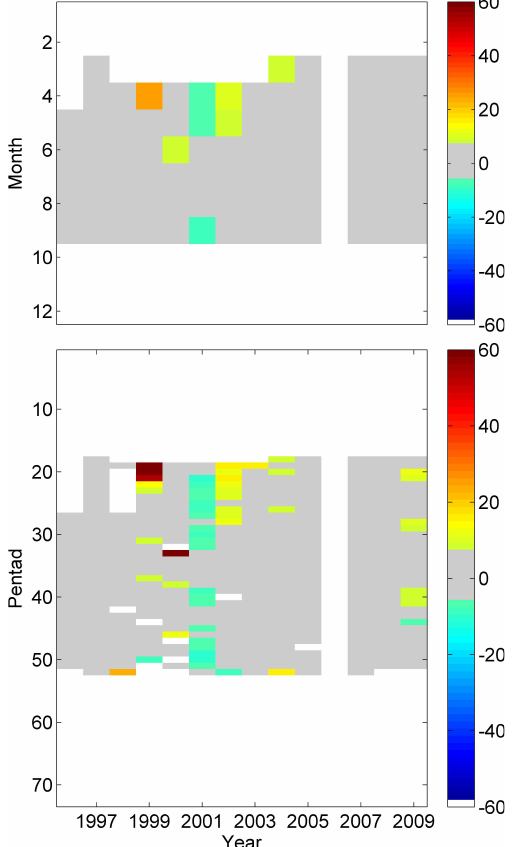
Fig. 5. Same as Fig. 3, but at Summit camp between 1996–2005 and 2007–2009.